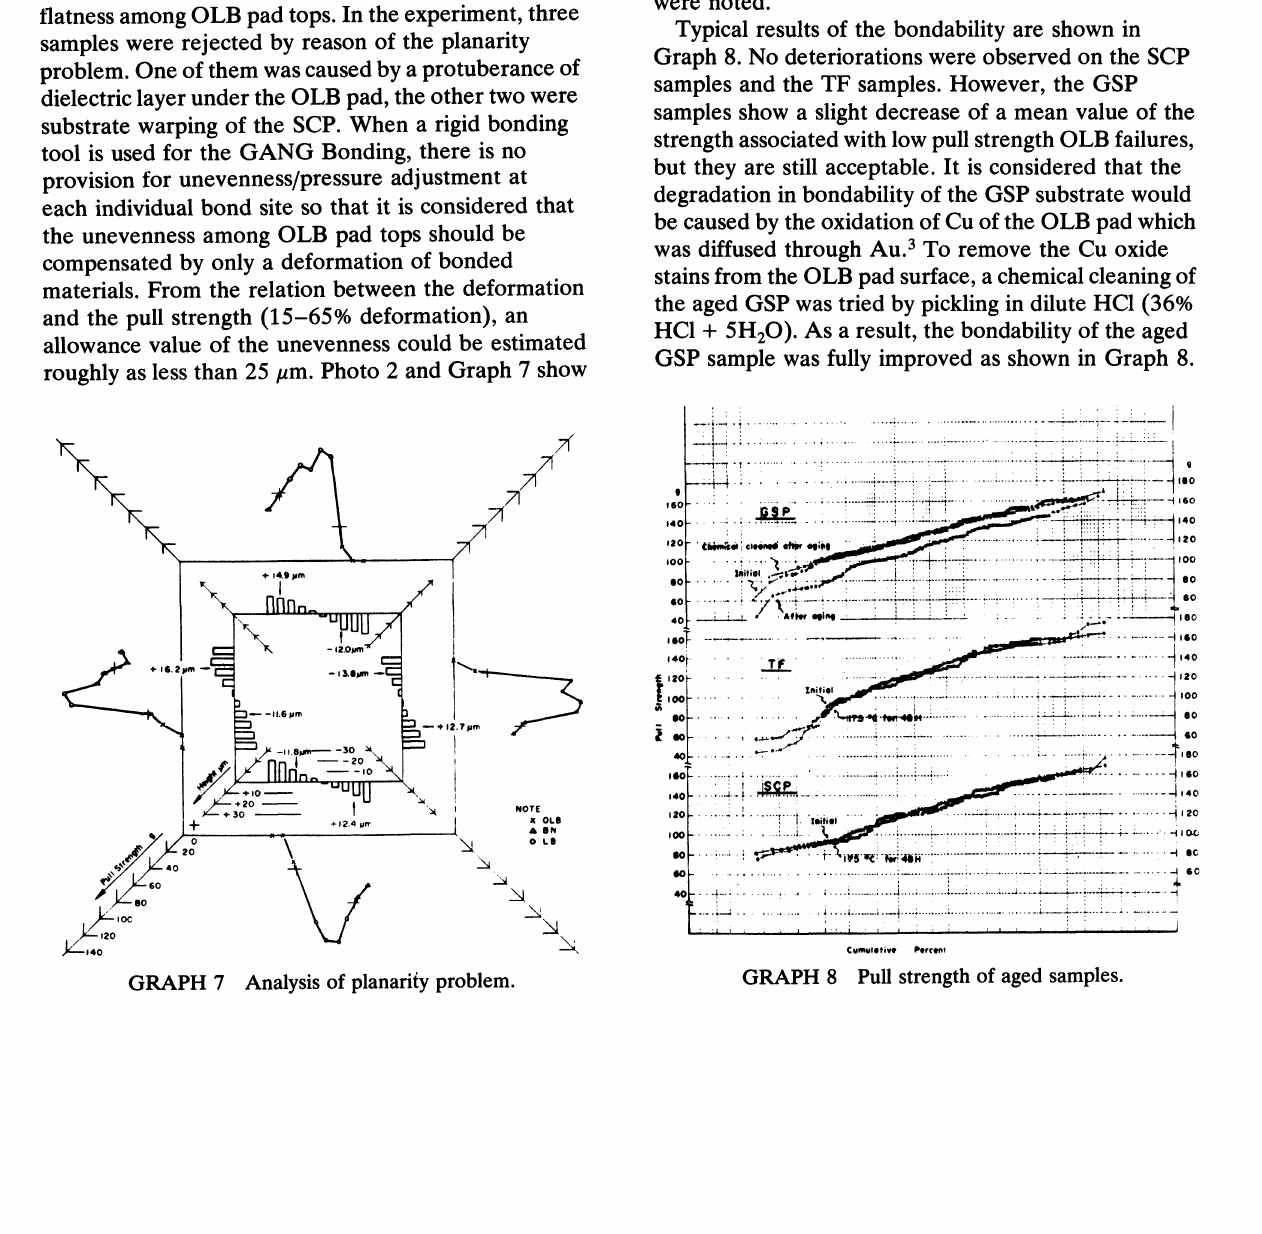
GRAPH 8 Pull strength of aged